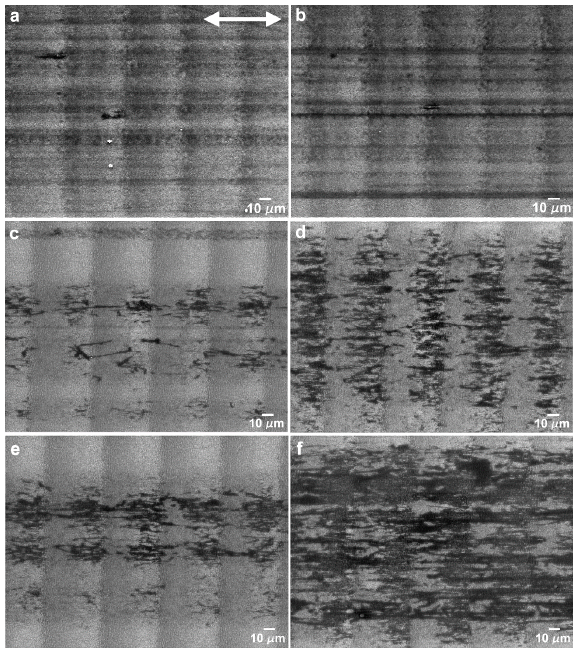
Figure 8. PTFE fibers drawn from a PTFE ribbon joining to form a thin film in zone B of the wear track produced at 25 mN illustrated in Figure 6b, taken at 45° tilt.